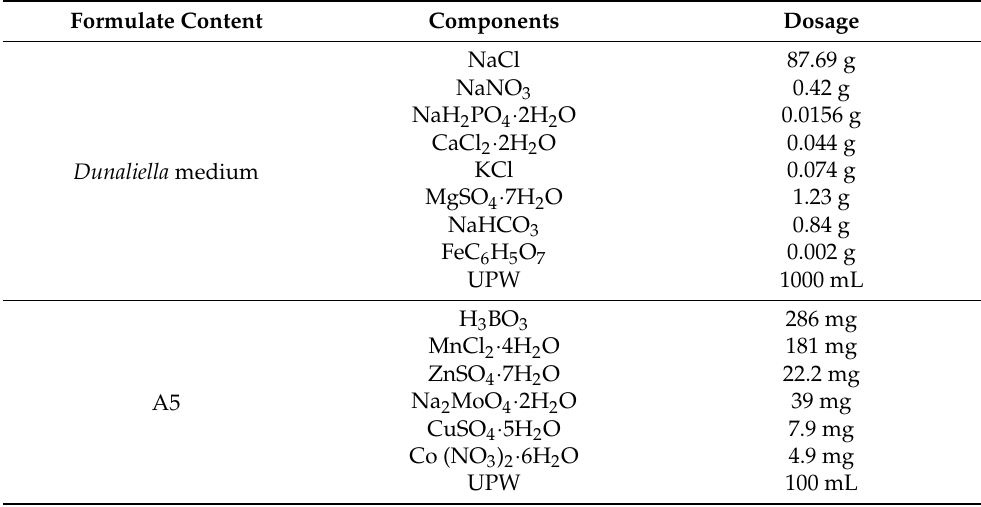
Table 2. Dunaliella